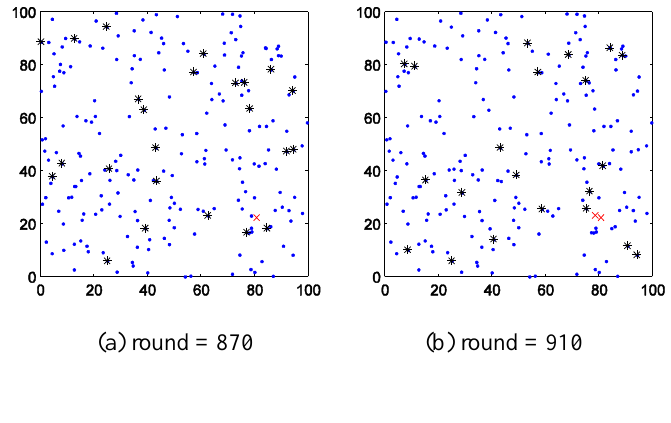
Figure 3. The distribution of fault nodes. * : cluster head node, • : simple nodes. × : fault node (a) the first fault node appeared; (b) & (c) several rounds later, more fault nodes appeared; (d) the number of fault nodes is so large that the network is